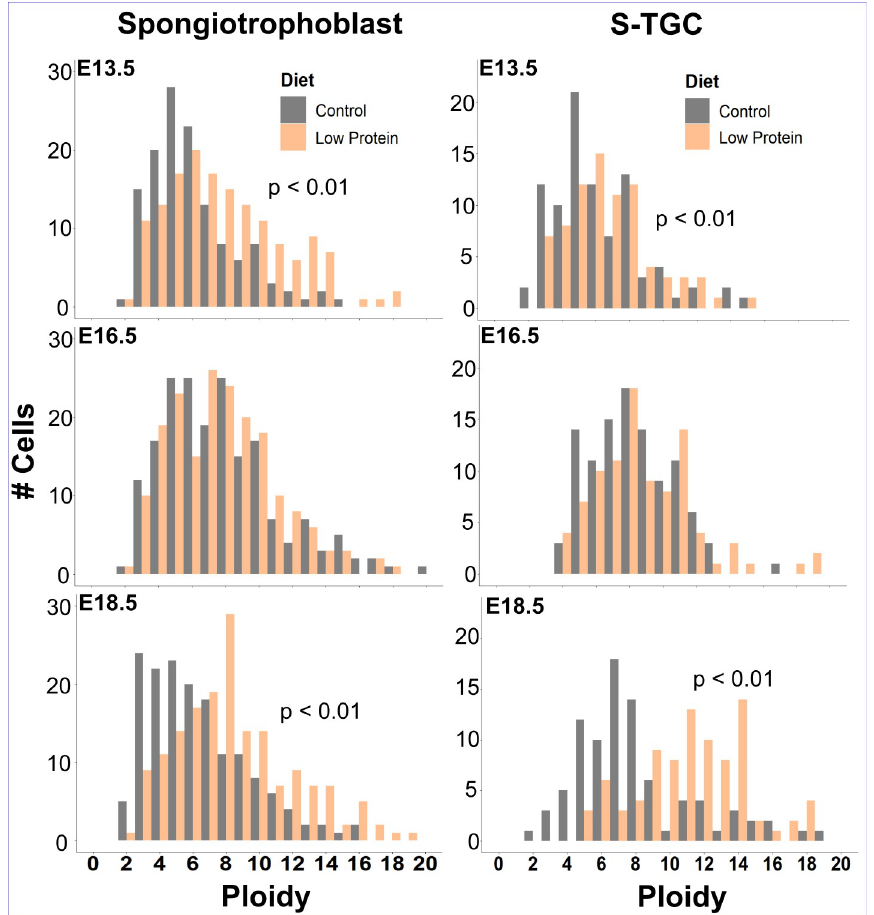
Fig 7. Sinusoidal trophoblast giant cell (S-TGC) and spongiotrophoblast (SpT) cell ploidy in control and protein- restricted pregnancies. (A) Frequency of S-TGCs at each ploidy level across gestation. (B) Frequency of SpT cells at each ploidy level across gestation (n =